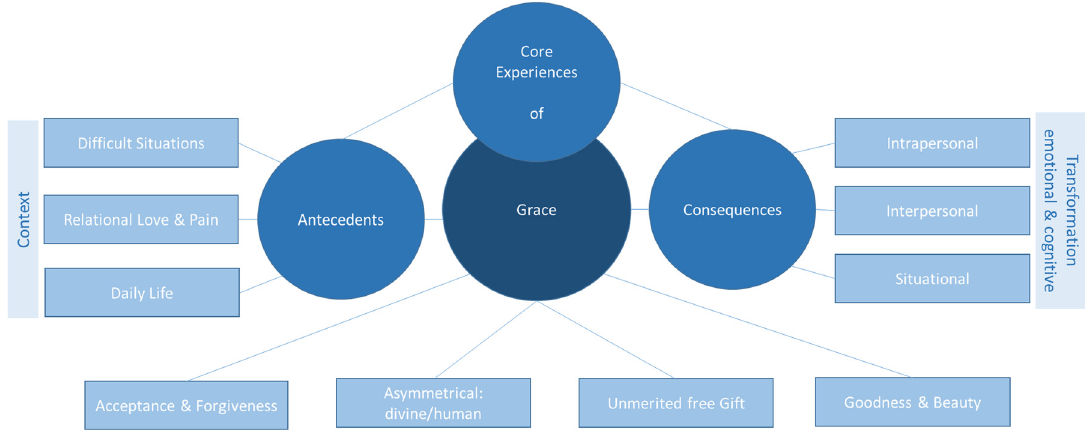
Figure 1: Experiencing grace: thematic